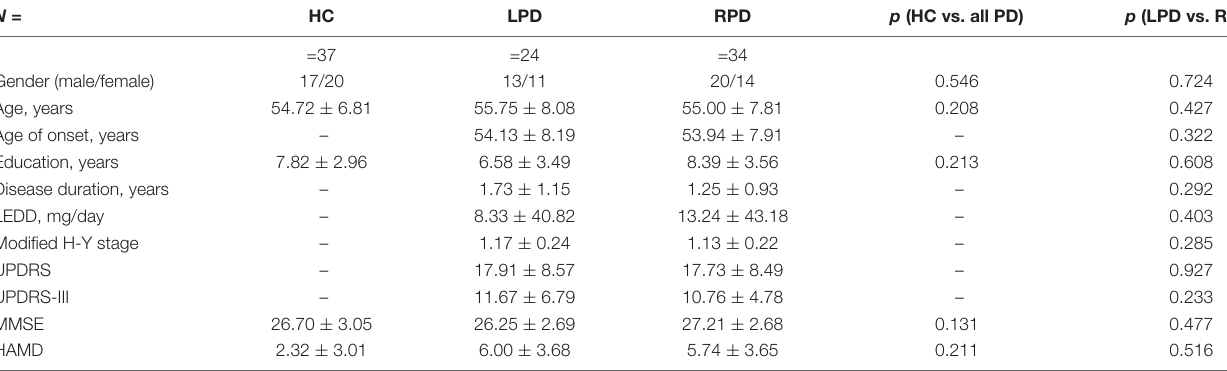
TABLE 1 | Demographic and clinical data of study groups.